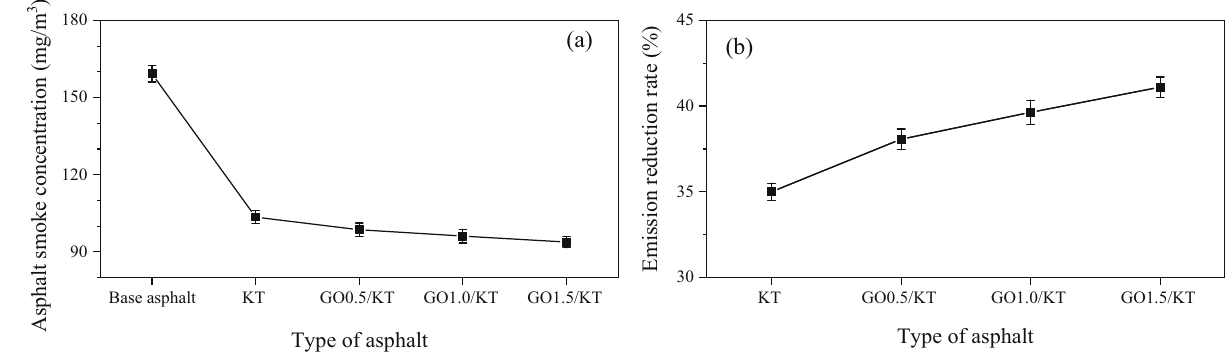
Figure 13: Asphalt smoke concentration ( a ) and emission reduction rate ( b ) of di ff erent types of